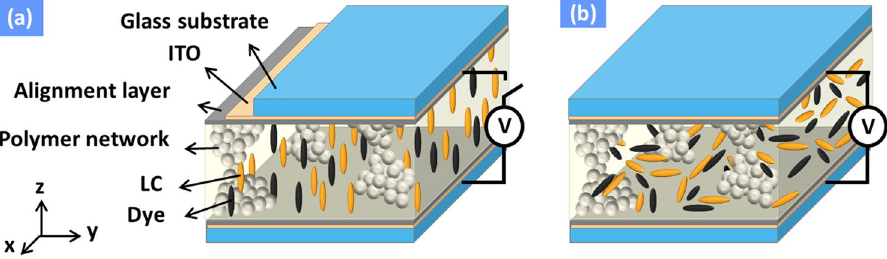
Figure 3. The operating principles of LC attenuator at ( a ) voltage-off state and ( b ) voltage-on state.